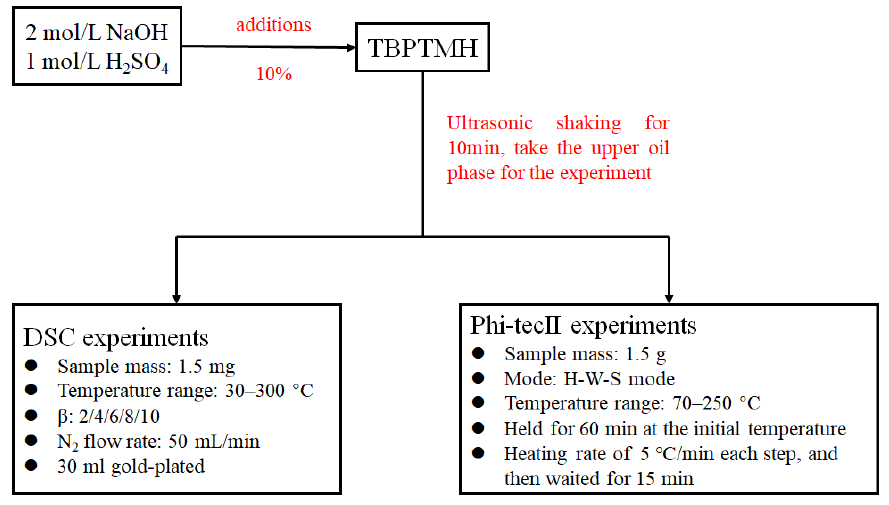
Figure 2. The experimental flow chart.